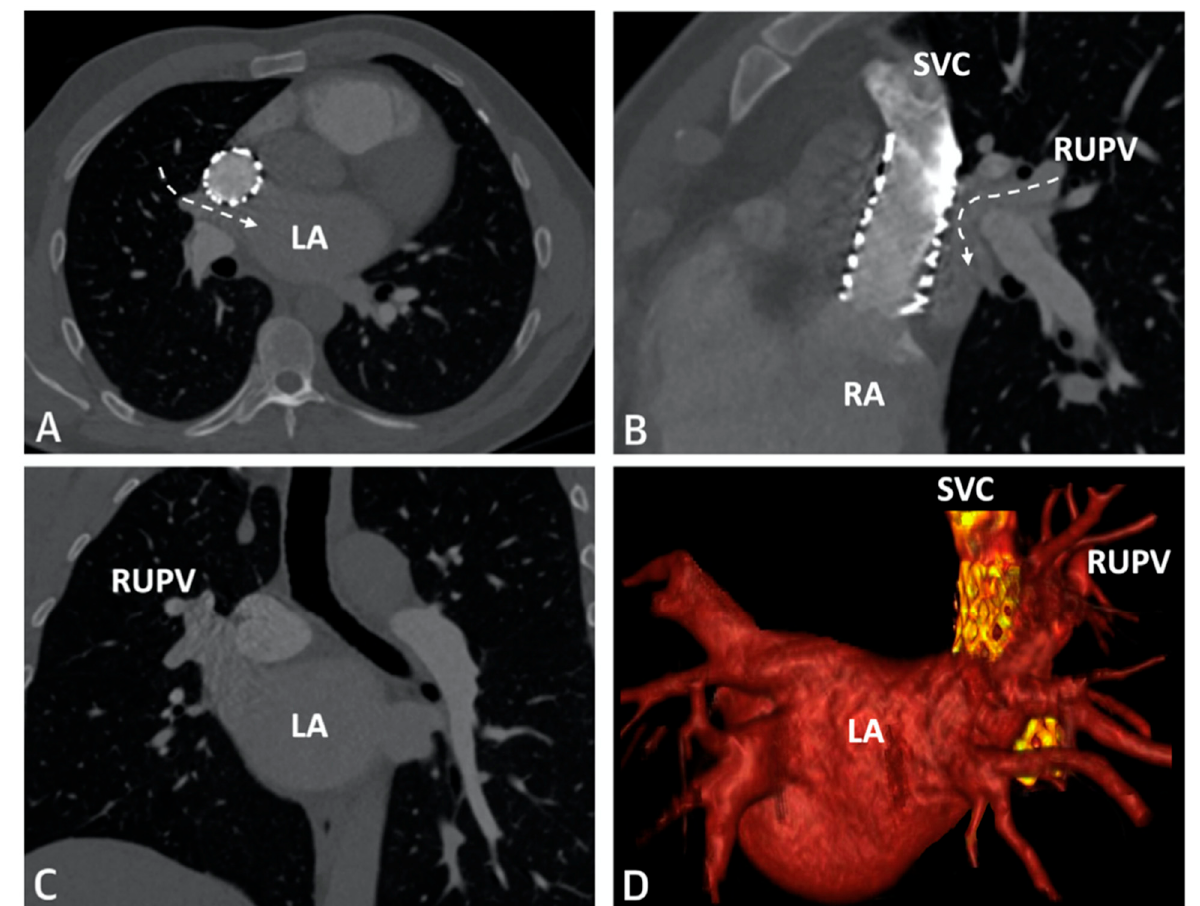
Figure 6. CT imaging following successful covered stent placement demonstrates no pulmonary venous obstruction to the LA ( A – C ). A 3D virtual model confirms unobstructed drainage from the pulmonary veins to the LA ( D ). Revised from ref [4].